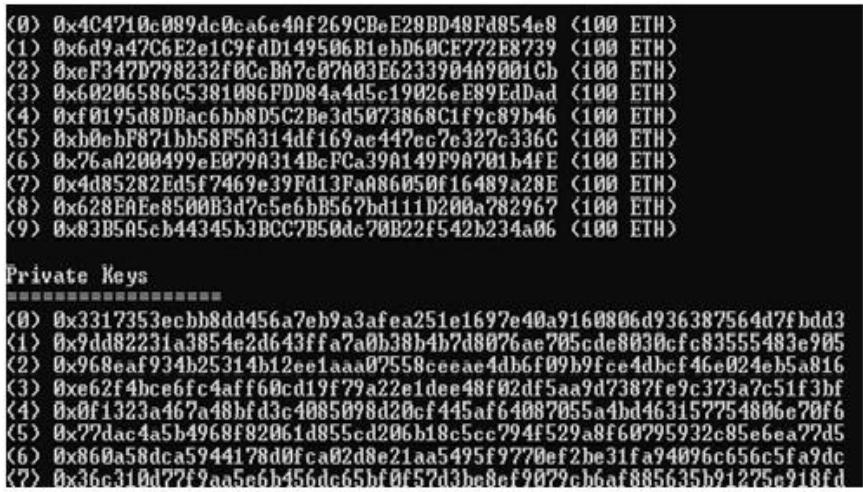
Figure 7. Available accounts to